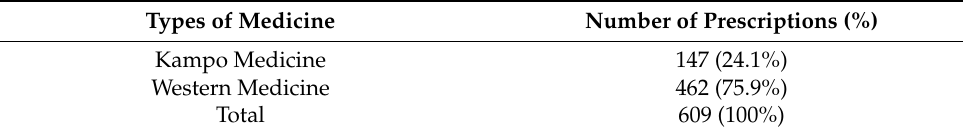
Table 2. Number of prescriptions (%) for patients who visited the CAC clinic classified as Kampo medicine and Western medicine with focus on general fatigue.